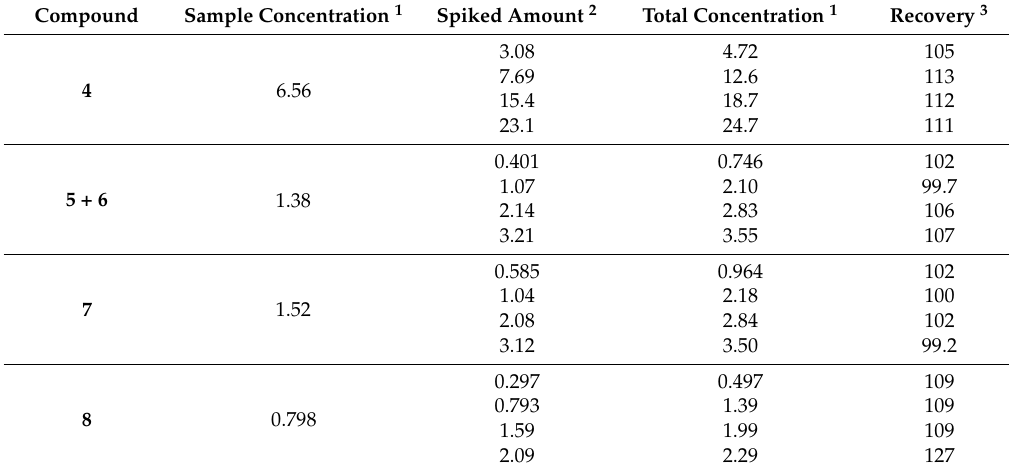
Table 3. Accuracy of the UHPLC